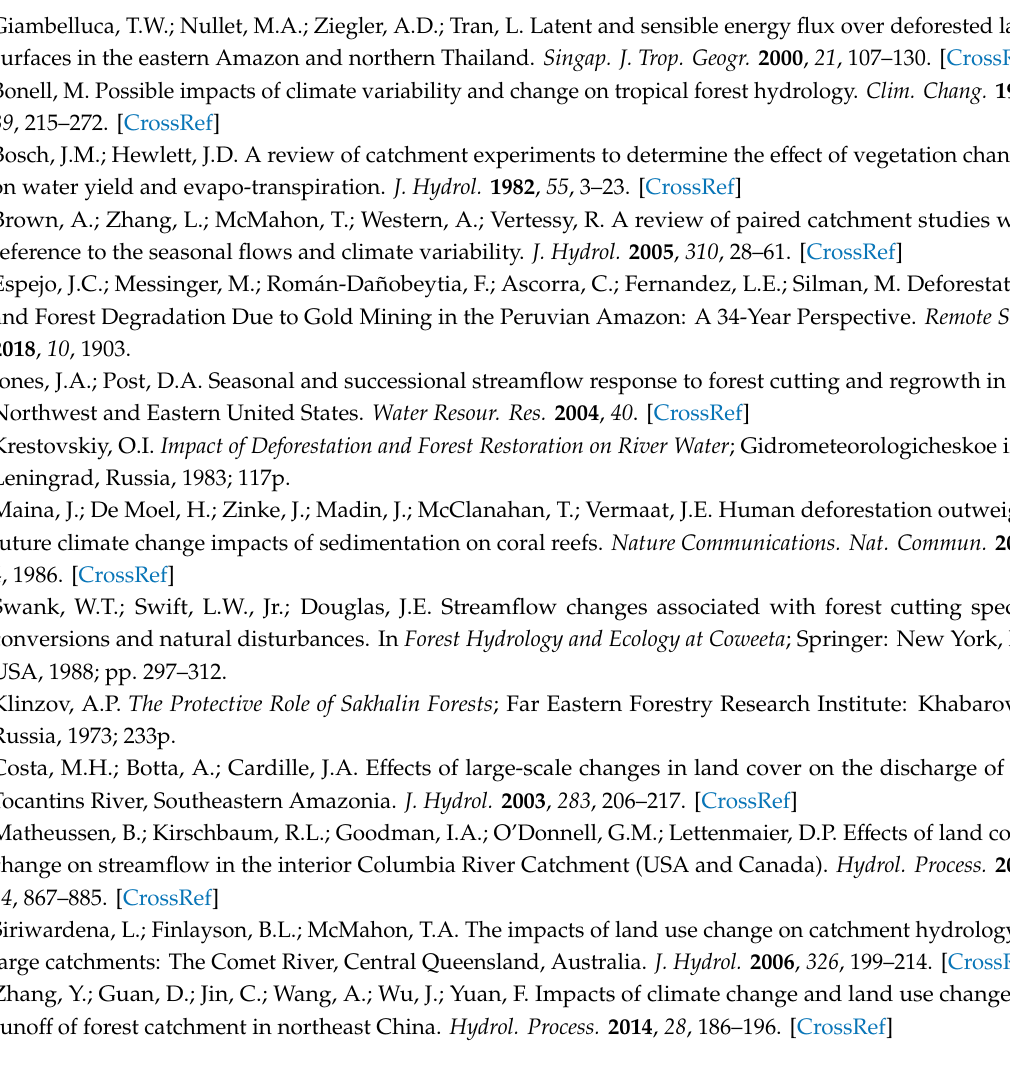
Figure A5. Vegetation dynamics of Manoma River watershed. Stream gaging is marked with the white diamond.